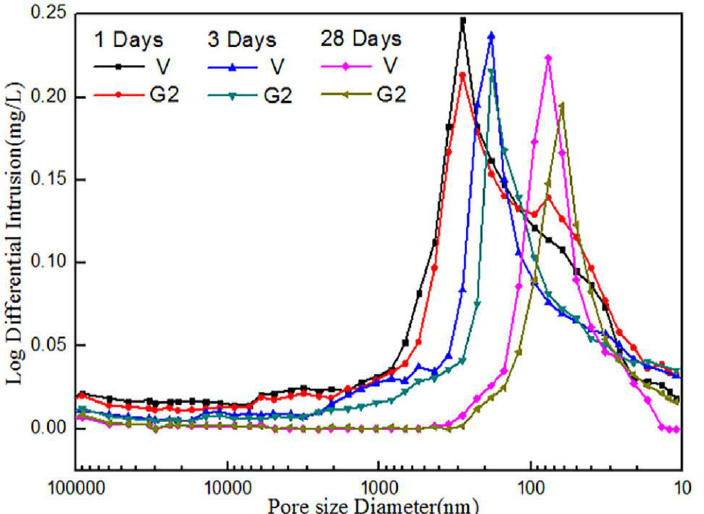
Figure 18. Pore size distribution of GNP/cement composites. Reprinted with permission from